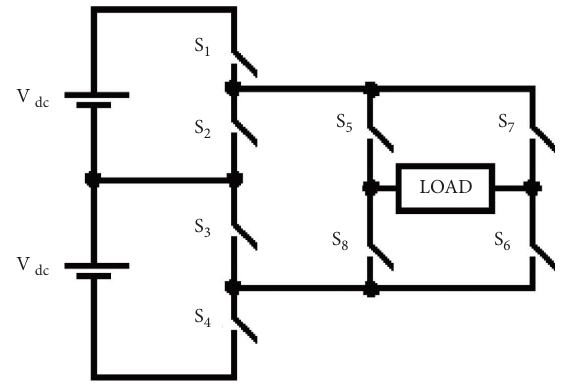
Figure 1: MLI topology presented in